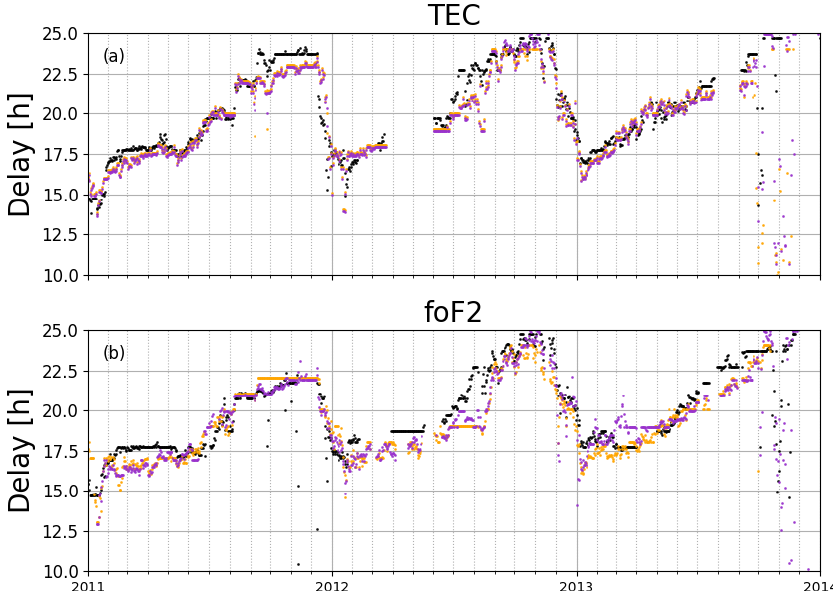
Figure 10. The plots show the delays of the ionospheric parameters TEC (a) and fo F2 (b) with integrated EVE fluxes (6 to 105nm) for Darwin (black), Camden (orange), and Canberra (purple). All parameters were analyzed at an hourly resolution using a time window of 90d and a step size of